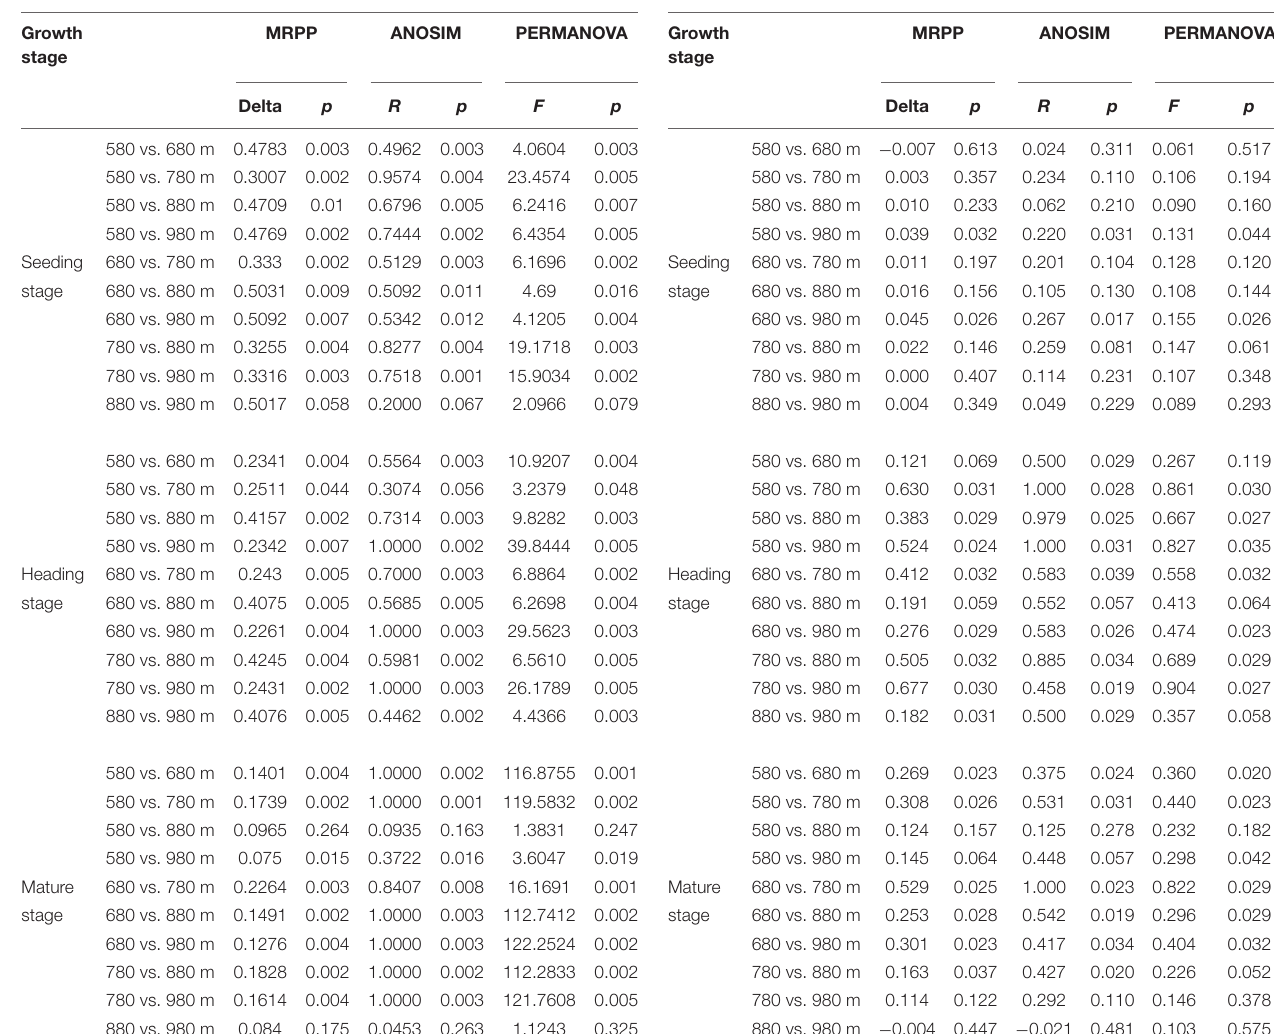
TABLE 5 | Dissimilarity test of phyllosphere fungal community between two different sample groups among different elevations at the seedling, heading, and mature